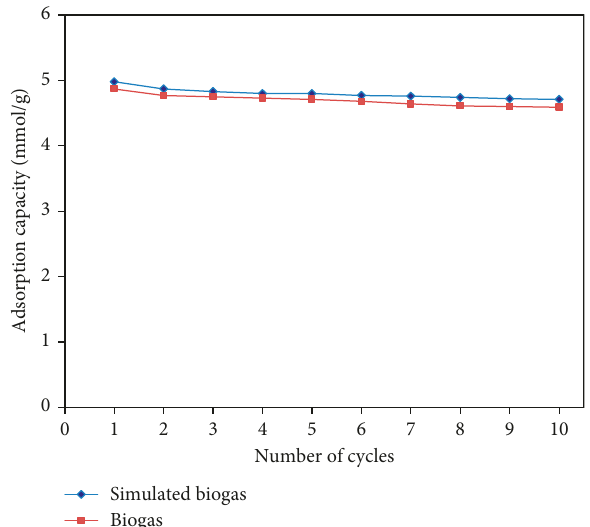
Figure 6: Cyclic CO 2 adsorption capacities of